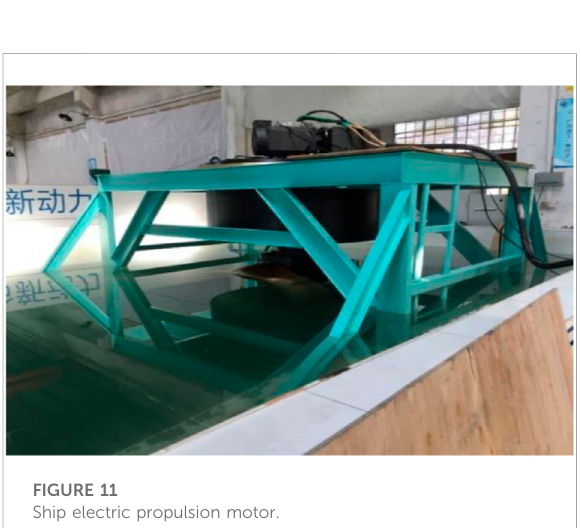
FIGURE 10 Inverter experiment platform.